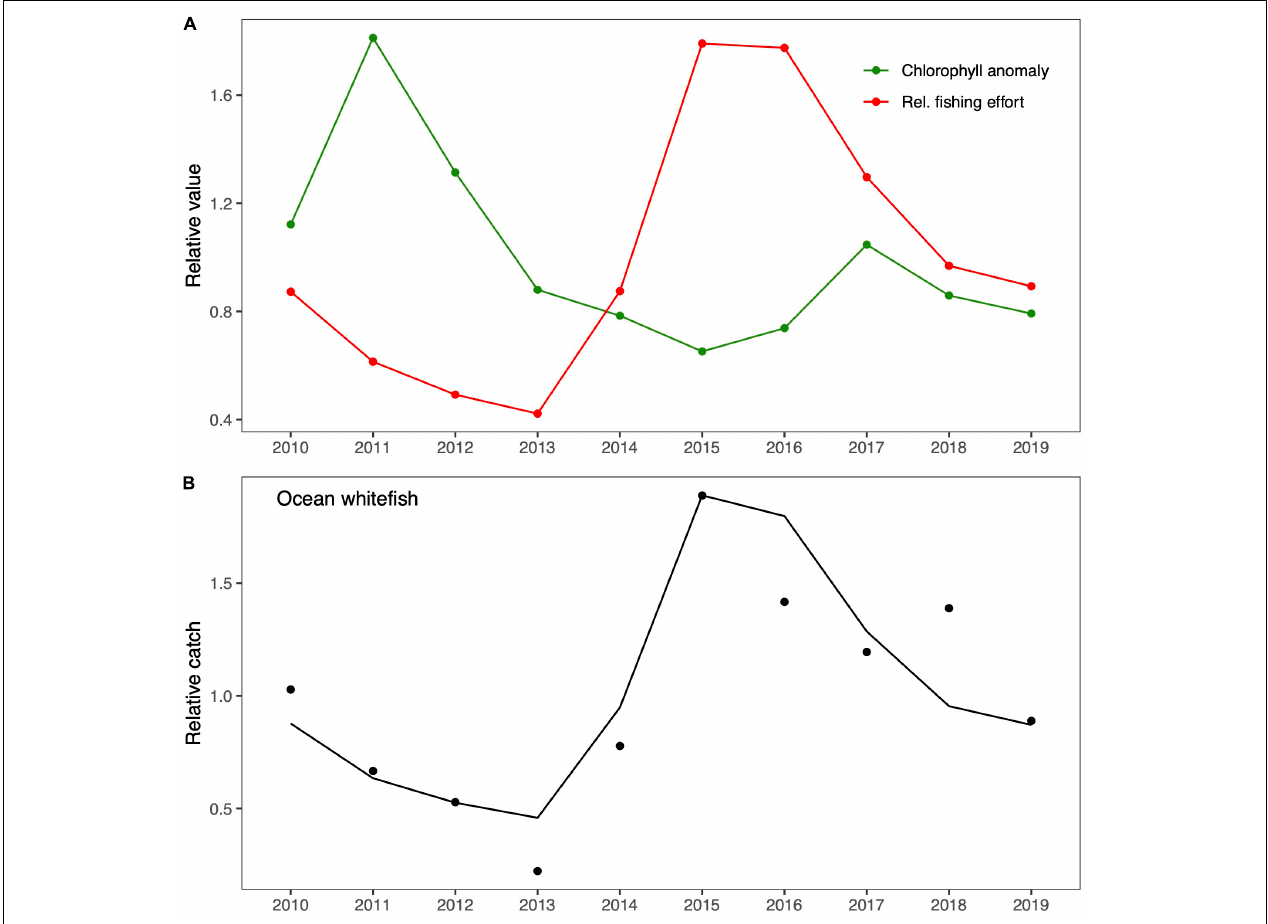
FIGURE 3 | Fitting of the Isla Natividad EwE model. (A) The forcing drivers, namely, satellite-derived chlorophyll-a anomaly and the relative fishing effort, are shown in green and red, respectively. (B) The fitted trends of historical and predicted relative catches are shown by black dots and black lines,